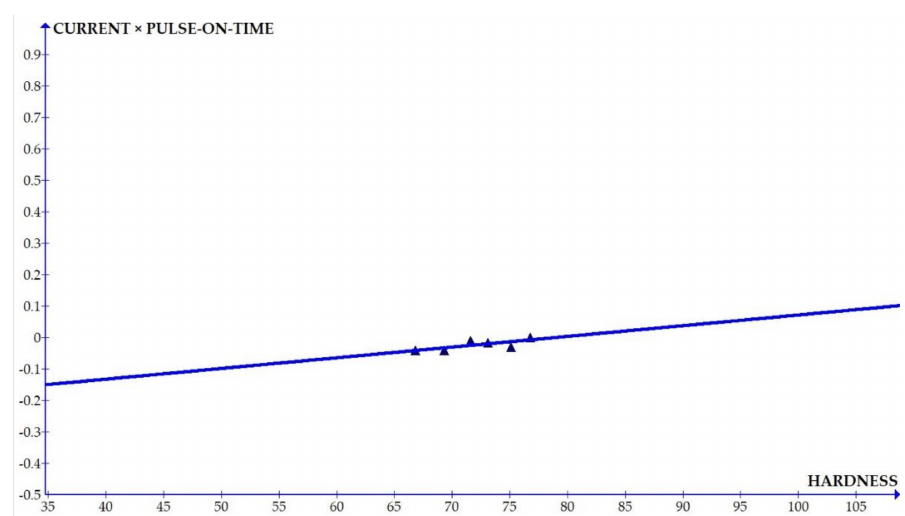
Figure 14. Coefficient of surface roughness: WFR × current vs. hardness.